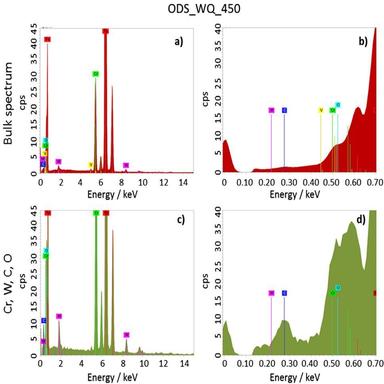
STEM-EDX spectra represented by counts per second (cps) versus energy plots from a) the bulk and c) a C, O, Cr, W enriched sub-micron particle of ODS_WQ_450. b) and d) shows the spectrum at low energy values to distinguish the C and O peaks in the bulk and the sub-micron particle, respectively